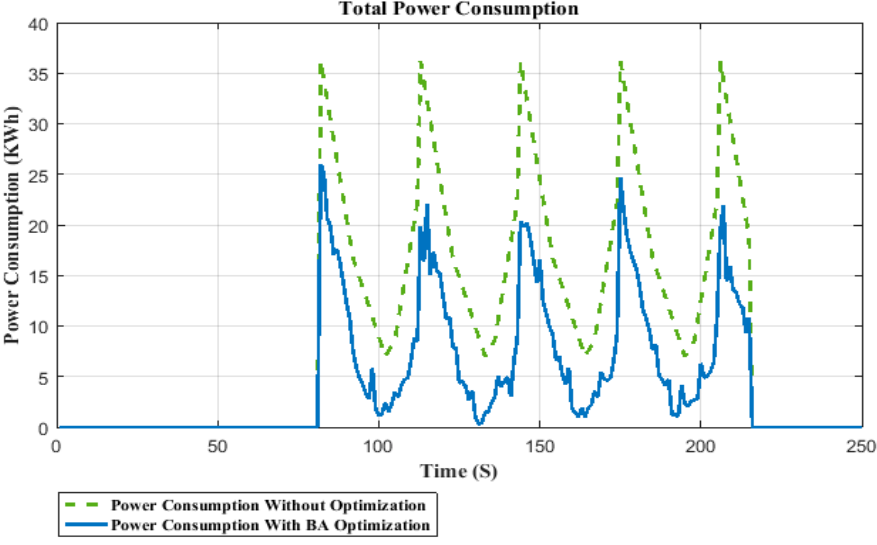
Figure 20. The total power consumption using BA and without using BA.